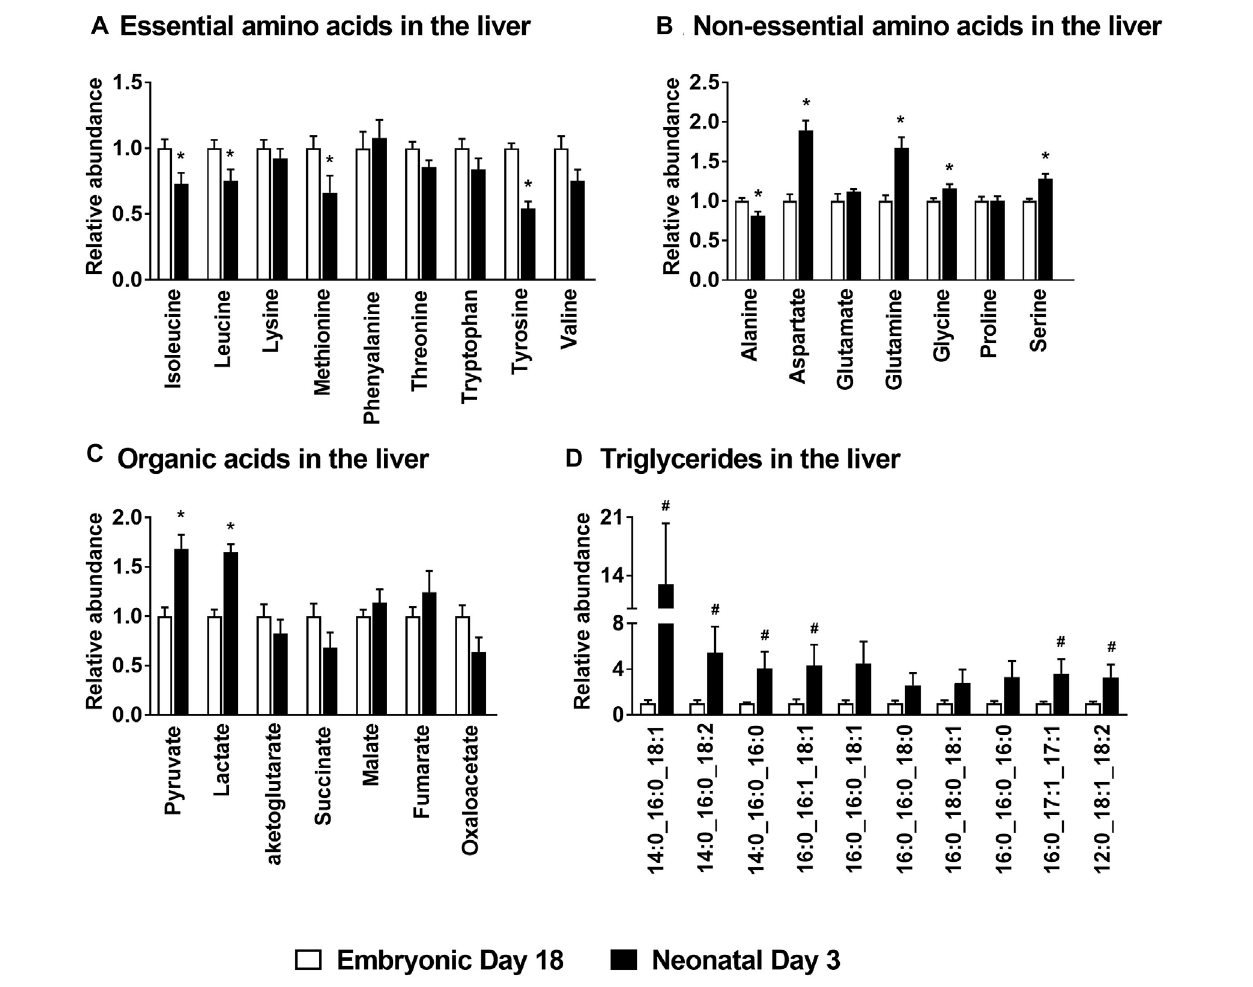
FIGURE 2 | Metabolite pro fi le of the embryonic and neonatal chicken liver. Changes in neonatal liver metabolites are presented relative to those of embryonic day 18. Pro fi les of (A) Essential amino acids; (B) Non-essential amino acids; (C) Organic acids associated with mitochondrial TCA cycle and (D) Hepatic triglycerides in embryosandneonatesfromleghornlayer fl ock.Allthevaluesarerepresentedasmeans±SEMwith n =6 – 9birds/group.Resultswereconsideredsigni fi cantat p ≤ 0.05 ( * ) or a trend at p ≤ 0.1 ( # ) following a Student t -test between embryonic day 18 and neonatal day 3.